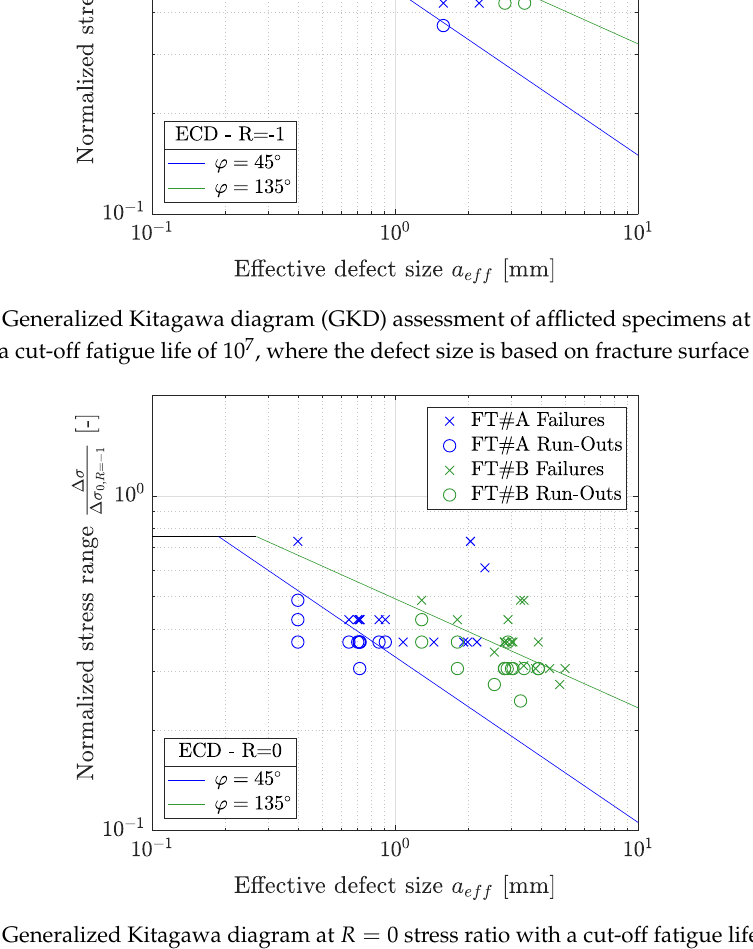
Figure 22. Generalized Kitagawa diagram at R = 0 stress ratio with a cut-off fatigue life of 10 7 , where the defect size is based on fracture surface